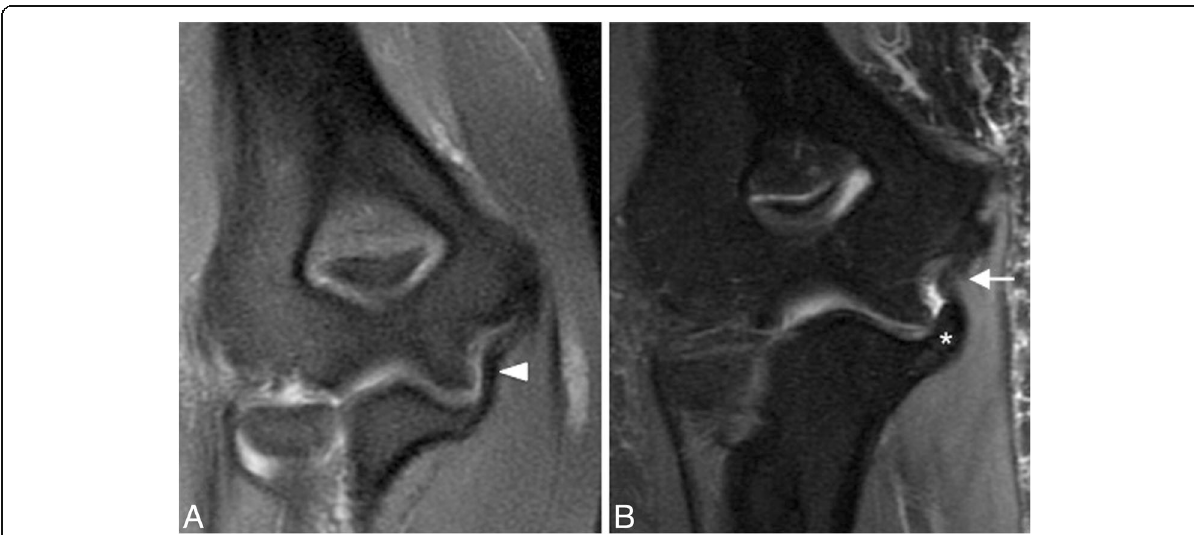
Fig. 18 Two different patients with chronic elbow pain and medial instability. Coronal FS PD-weighted MRI ( a ) showing a chronically thickened anterior bundle of the medial collateral ligament (white arrowhead). Coronal FS PD-weighted MRI ( b ) showing a chronically thickened anterior bundle of the medial collateral ligament (white arrow), and a deformity of the sublime tubercle due to malunion of an old fracture (white asterisk)